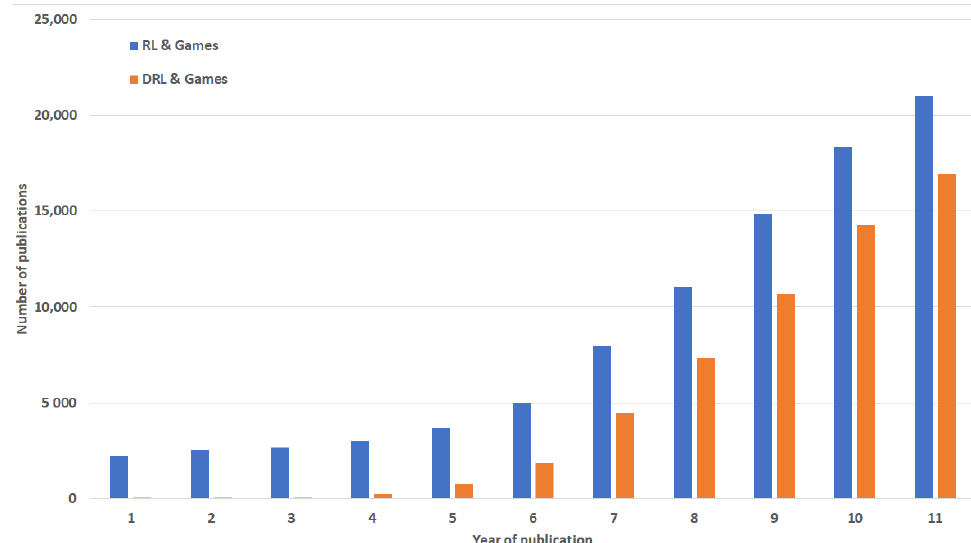
Figure 3. Deep reinforcement learning and games publications per